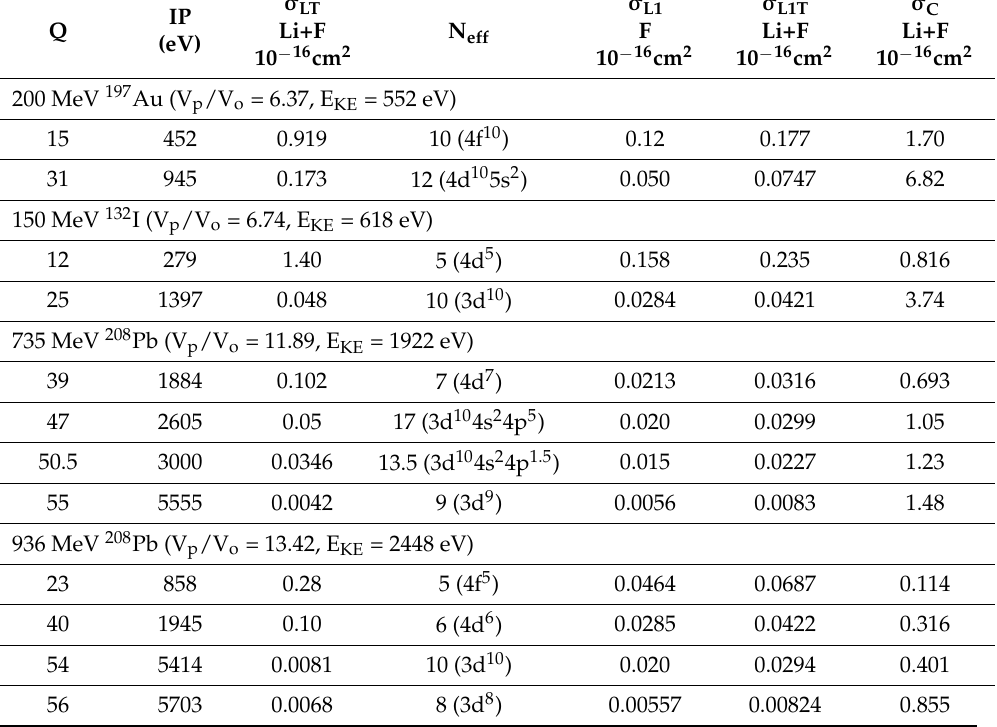
Table 8. Charge state Q in LiF relevant to this study, the first ionization potential (IP eV) [67], total electron loss cross section ( σ LT ) [62], single electron loss cross section ( σ L1 ) [63,64] and single electron capture [68] in 10 − 16 cm 2 for 200 MeV Au, 150 MeV I, 735 MeV Pb and 936 MeV Pb with Q. N eff is the number of removable electrons. The electronic configurations contributing to N eff for the projectile ions are given in the parenthesis. σ L1T = σ L1 (Li) + σ L1 (F). Projectile velocity (V p ) divided by Bohr velocity (V o ) and the kinetic energy (E KE ) of the electron with V p are given in the parenthesis after the energy and ion.